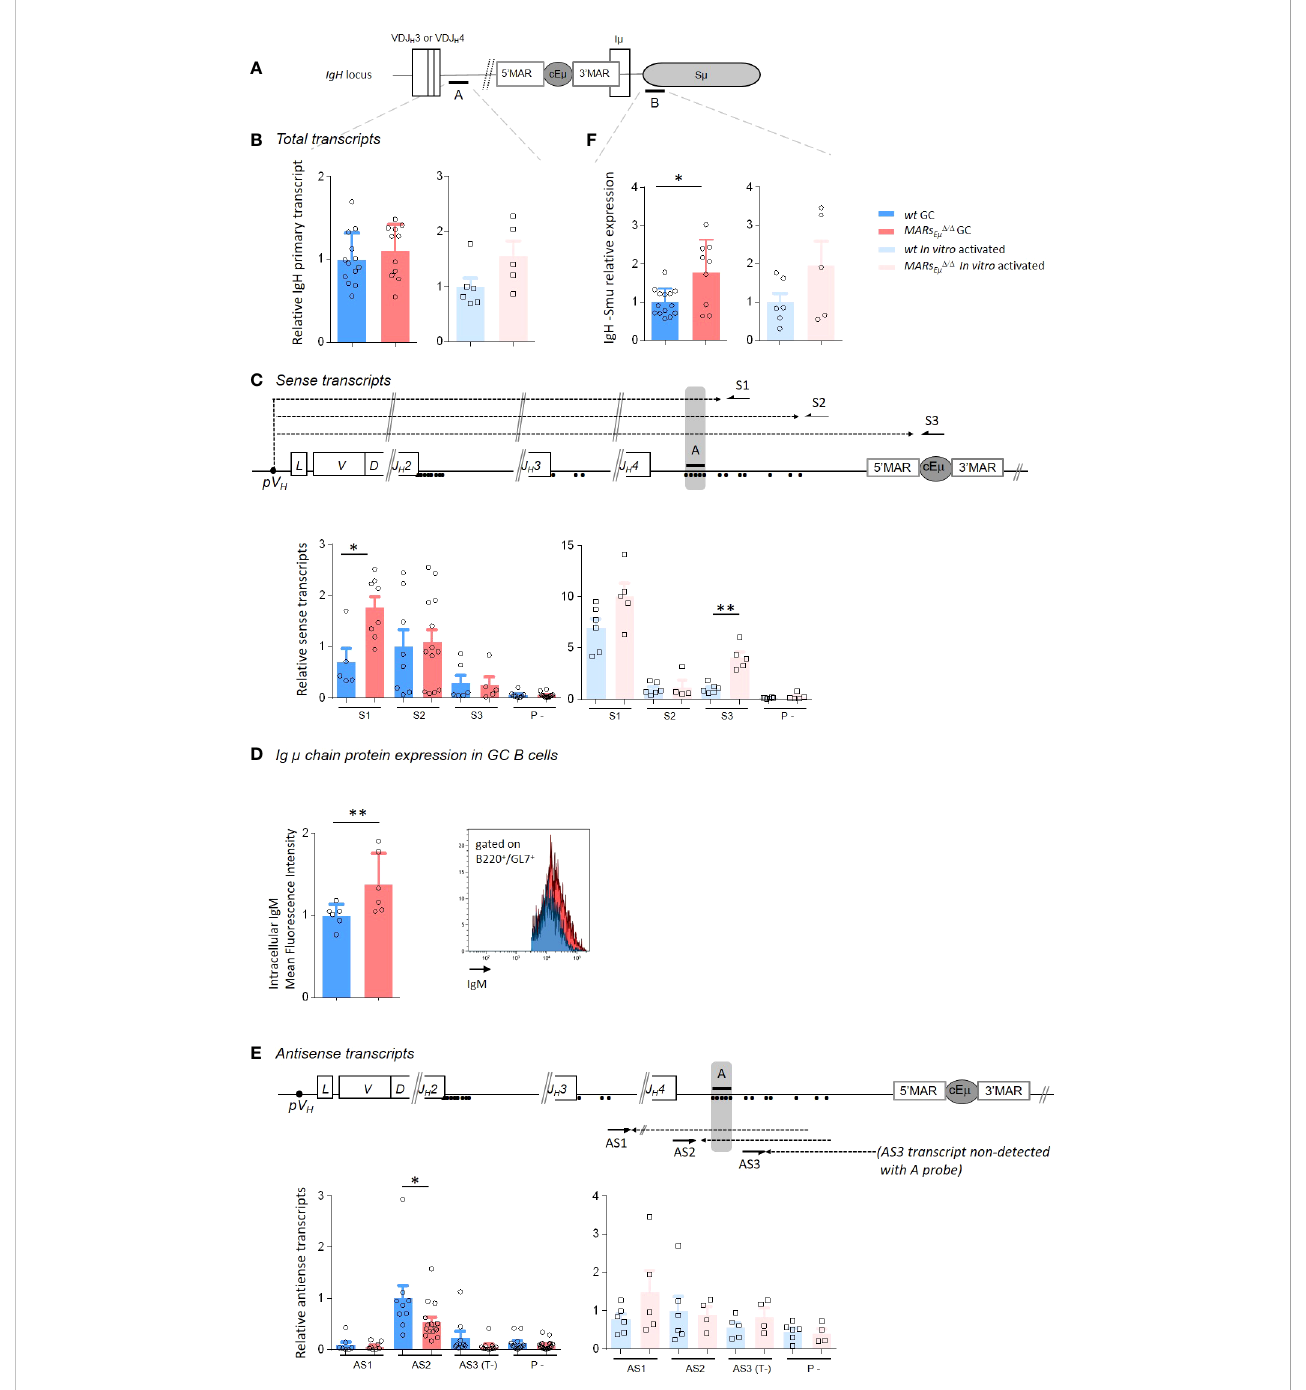
FIGURE 3 MARs Eμ deletion impairs strand-speci fi c transcription upstream from Eμ region. (A) IgH locus specifying location of q-PCR probes (A, B) used for transcripts quanti fi cation. (B) Total primary transcripts quanti fi ed downstream from the J H 4 segment with probe A in Peyer ’ s patch GC B cells (dark colors) and in vitro -activated B cells (light colors) from wt and MARs Eμ D / D mice. (C) Detection of sense transcripts (dotted arrows) in murine IgH locus (not to scale). Arrows indicate primers (S1, S2, S3) downstream from J H 3 and J H 4 used for strand-speci fi c reverse transcription. Primary sense transcripts were quanti fi ed with probe A (black bar) in Peyer ’ s patch GC B cells and in vitro -activated B cells from wt and MARs Eμ D / D mice. Dots indicate antisense transcript start sites according to Perlot et al. (38). Baseline levels were de fi ned by using a RT template performed without primers (P-). Bar graphs show the relative quantity of sense transcripts obtained from template S1, S2 and S3 (mean ± SEM) from two to three independent experiments. (D) Intracellular IgM mean fl uorescence intensity measured by fl ow cytometry in GC B cells from Peyer ’ s patches of wt and MARs Eμ D / D mice. Bar graphs indicate data from individual mice ( n =6 mice in 2 independent experiments, mean ± SEM); a representative example of cell count overlay is shown. (E) Detection of antisense transcripts (dotted arrows) in murine IgH locus (not to scale). Arrows indicate primers (AS1, AS2, AS3) downstream from J H 3 and J H 4 used for strand-speci fi c reverse transcription. Primary antisense transcripts were quanti fi ed with probe A (black bar) in Peyer ’ s patch GC B (dark colors) cells and in vitro -activated (light colors) B cells from wt and MARs Eμ D / D mice. Dots indicate antisense transcripts start sites according to the Alt study (38). Baseline levels were de fi ned by using a RT template performed without primers (P-) or by using a strand-speci fi c template that cannot be detected with A probe (T-). (F) Total primary transcripts quanti fi ed downstream from cEμ region with probe B in Peyer ’ s patch GC B cells (dark colors) and in vitro -activated B cells (light colors) from wt and MARs Eμ D / D mice. p-value was determined with two tailed Mann Whitney test; signi fi cant differences are indicated by: *P < 0.05; **P < 0.01 and error bars represent SEM of two to three independent